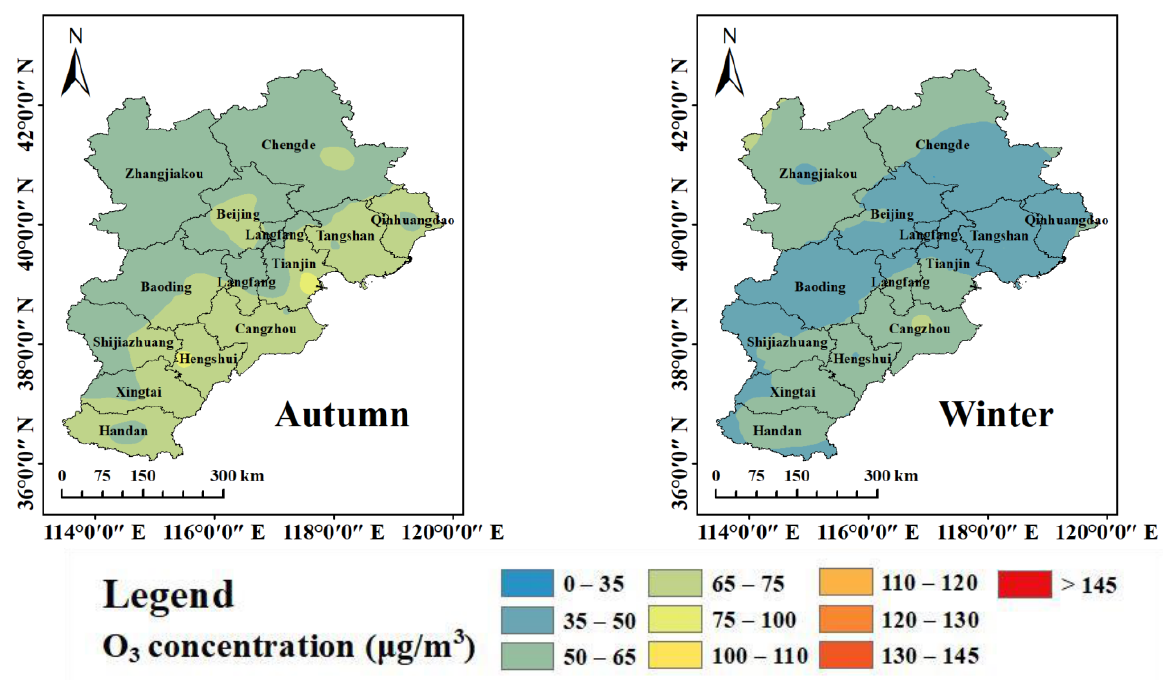
Figure 10. Spatial distribution of seasonal maximum 8-h average O 3 concentration.